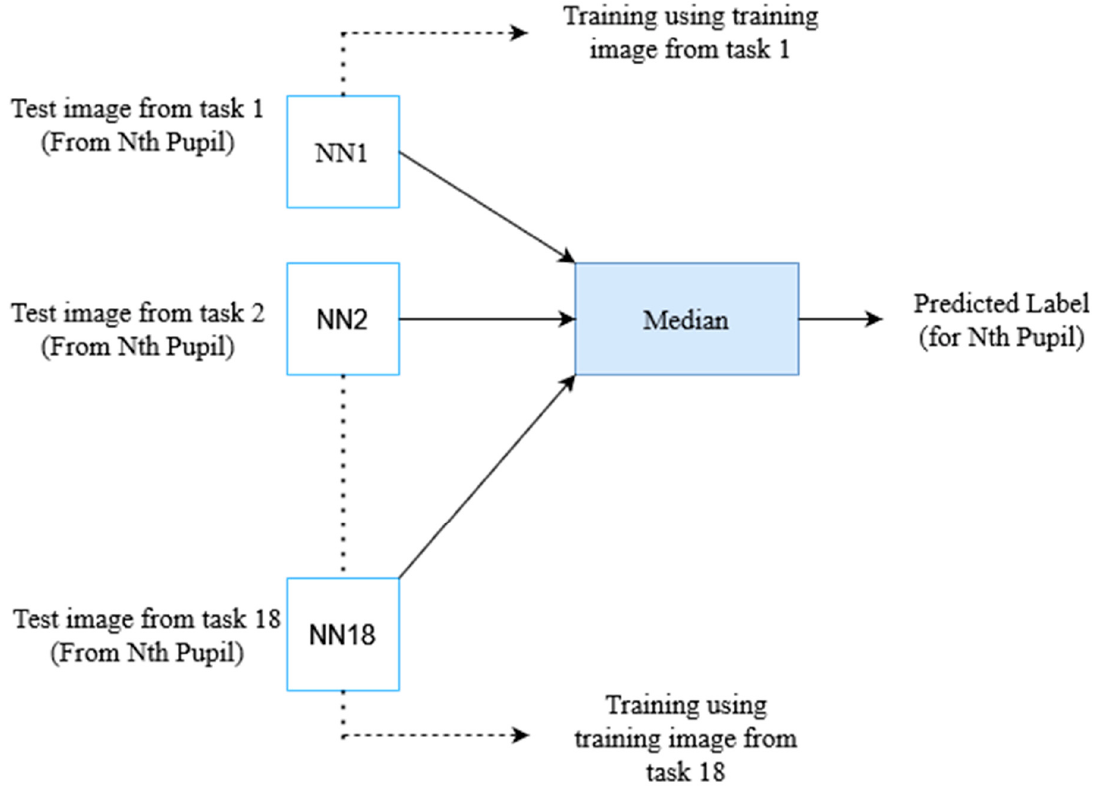
Figure 1. Block diagram depicting the proposed deep learning approach.